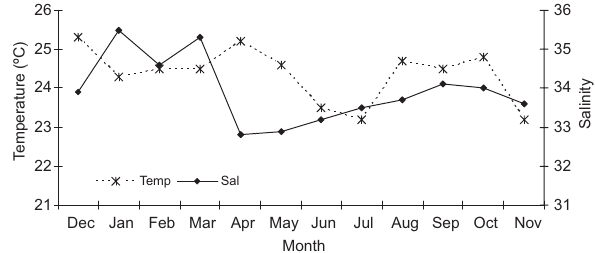
Figure 1. Water temperature and salinity during our study (De- cember, 2007 to November, 2008) of Echinaster ( Othilia ) guyanensis in southeastern Brazil. Each point represents one day.